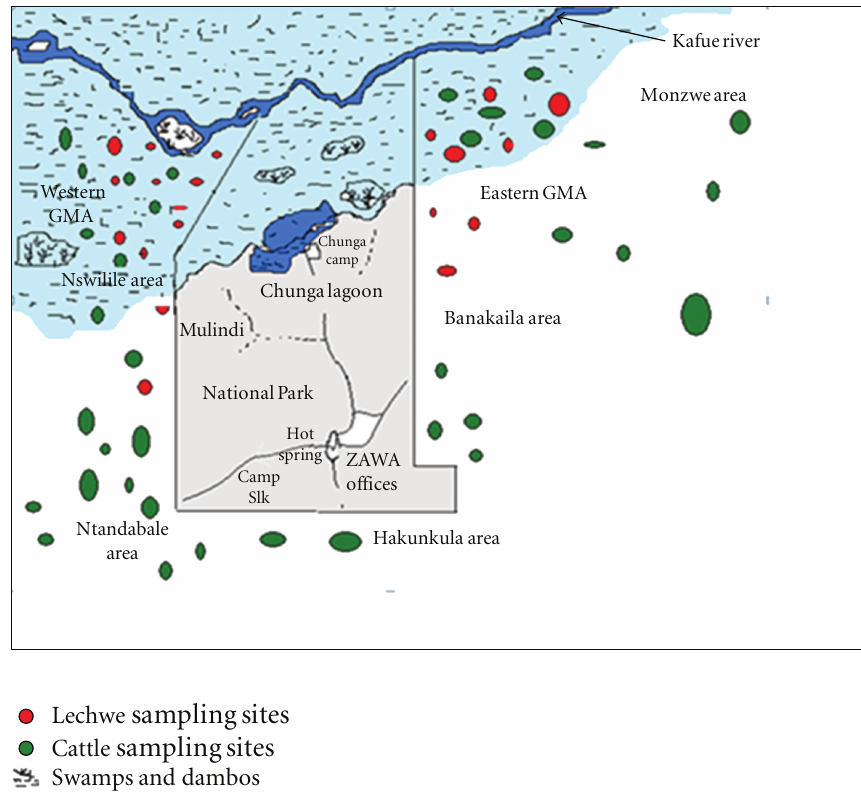
Figure 2: Map of Lochinvar indicating interacting sites of lechwe and cattle of the Kafue